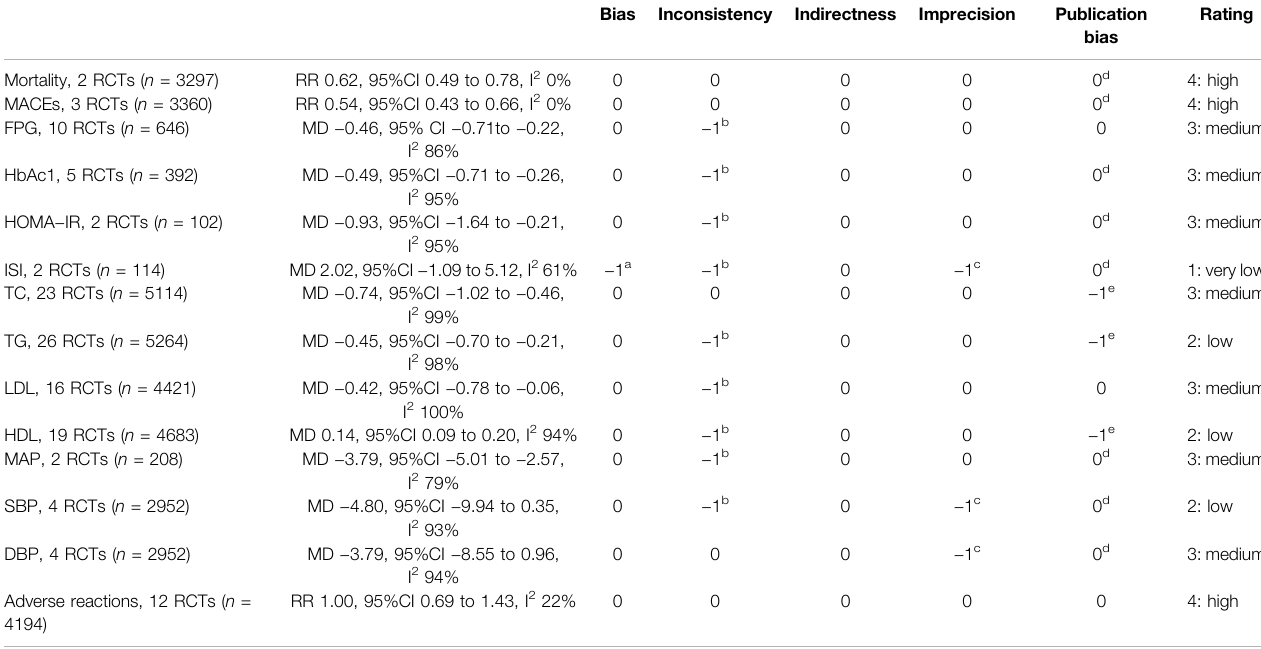
TABLE 2 | GRADE quality